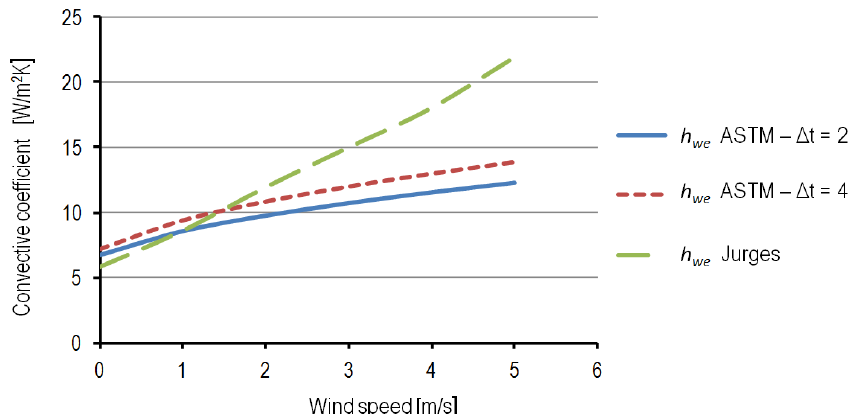
coefficient as a function of wind (cid:3050)(cid:3032)